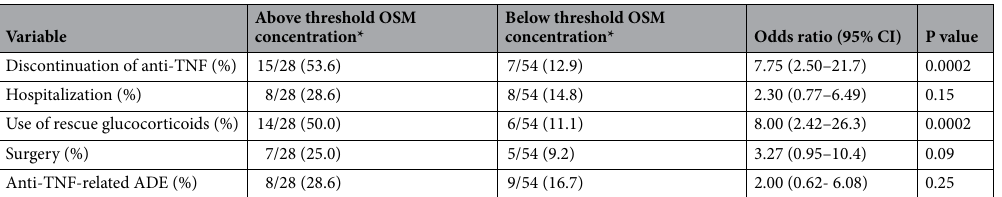
Table 4. Incidence of secondary outcomes in participants with Crohn’s disease. Oncostatin-M, OSM; confidence interval, CI; tumor necrosis factor-α, TNF; adverse drug event. *Threshold OSM concentration in Crohn’s disease is defined as 168.7 pg/ml.